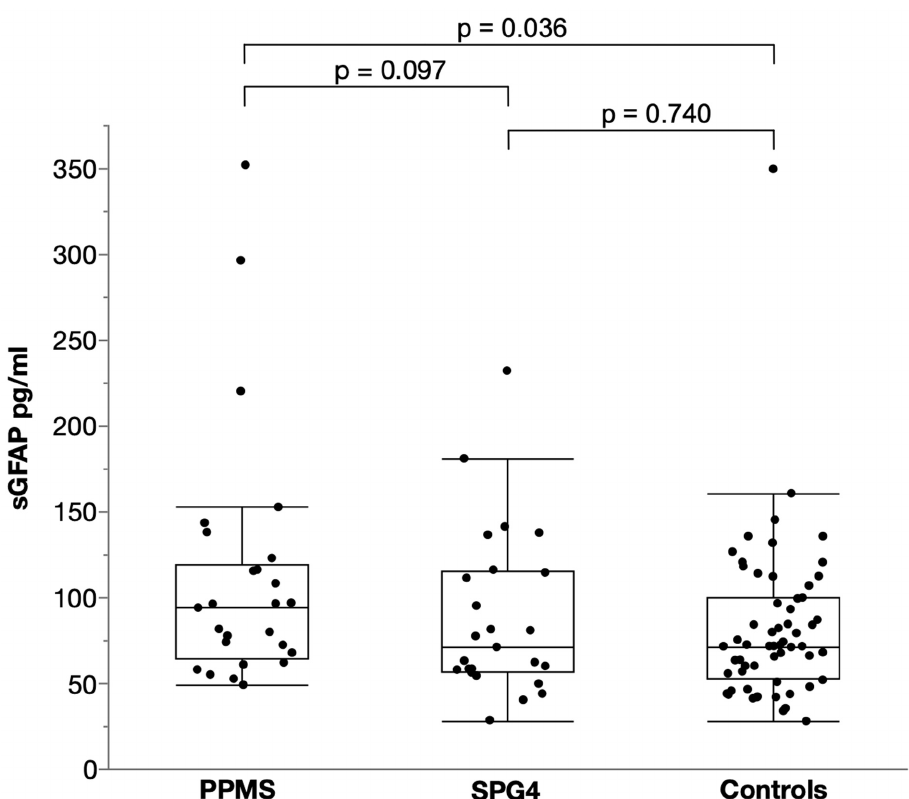
Figure 2. Scatter and box plot of serum GFAP levels in PPMS, SPG4 and controls. Horizontal lines represent medians, boxes show interquartile ranges and whiskers extend to the outermost data points within 1.5 interquartile ranges. Levels of sNfL and sGFAP were significantly correlated in PPMS (Spearman’s ρ = 0.563, p = 0.003), SPG4 (Spearman’s ρ = 0.630, p = 0.001) and controls (Spearman’s ρ = 0.527, p < 0.001) (Figure 3).